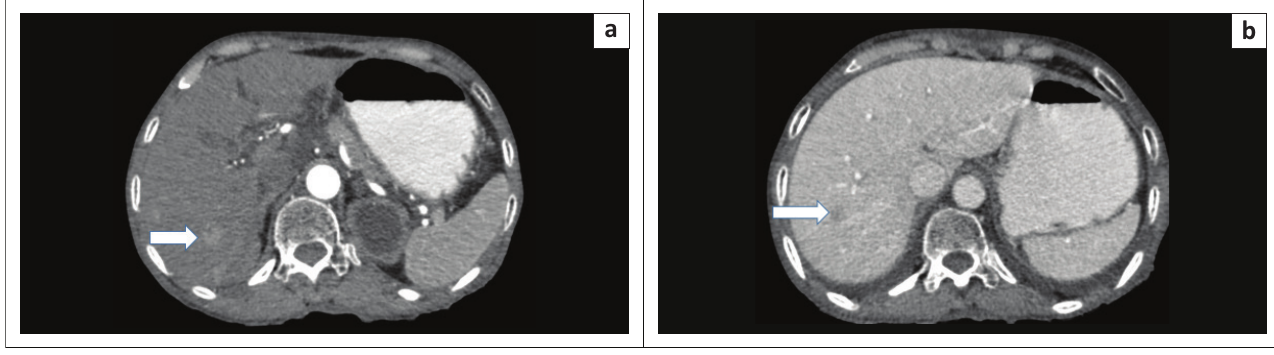
FIGURE 2: (a–b) Axial CT abdomen- arterial (a) and portal phase (b) revealing a hepatic metastasis (white arrow) in segment VI appearing hyperdense in the arterial and hypodense in the portal phase.